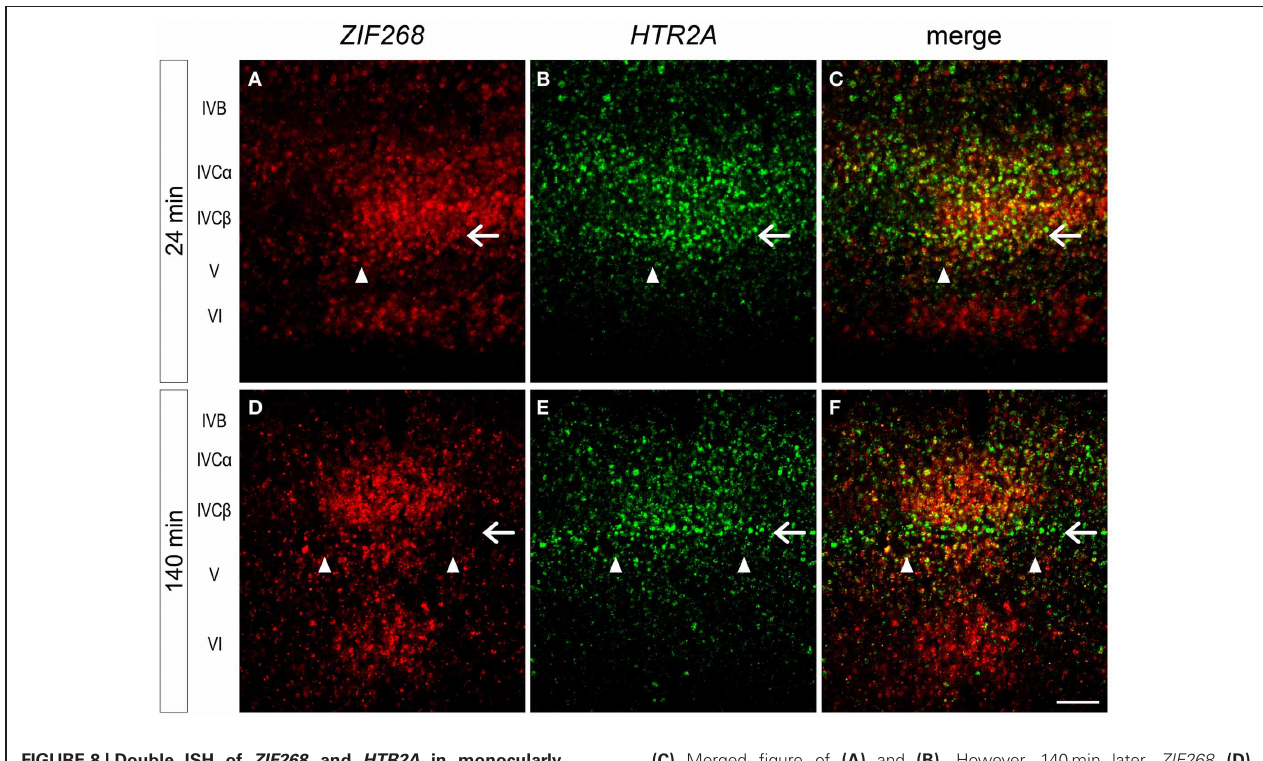
FIGURE 8 | Double ISH of ZIF268 and HTR2A in monocularly stimulated marmoset V1. ZIF268 (A) and HTR2A (B) mRNAs were coexpressed at the border between layers IVC β and V in the active-eye columns 24min after light induction (white arrow).